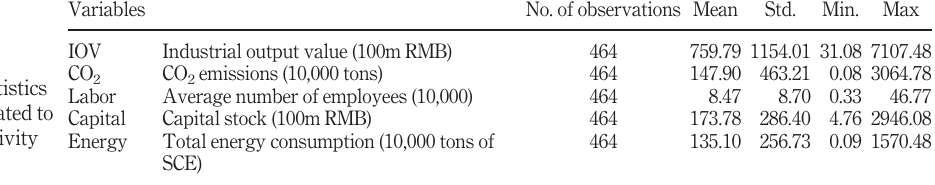
of variables related to carbon productivity measurement